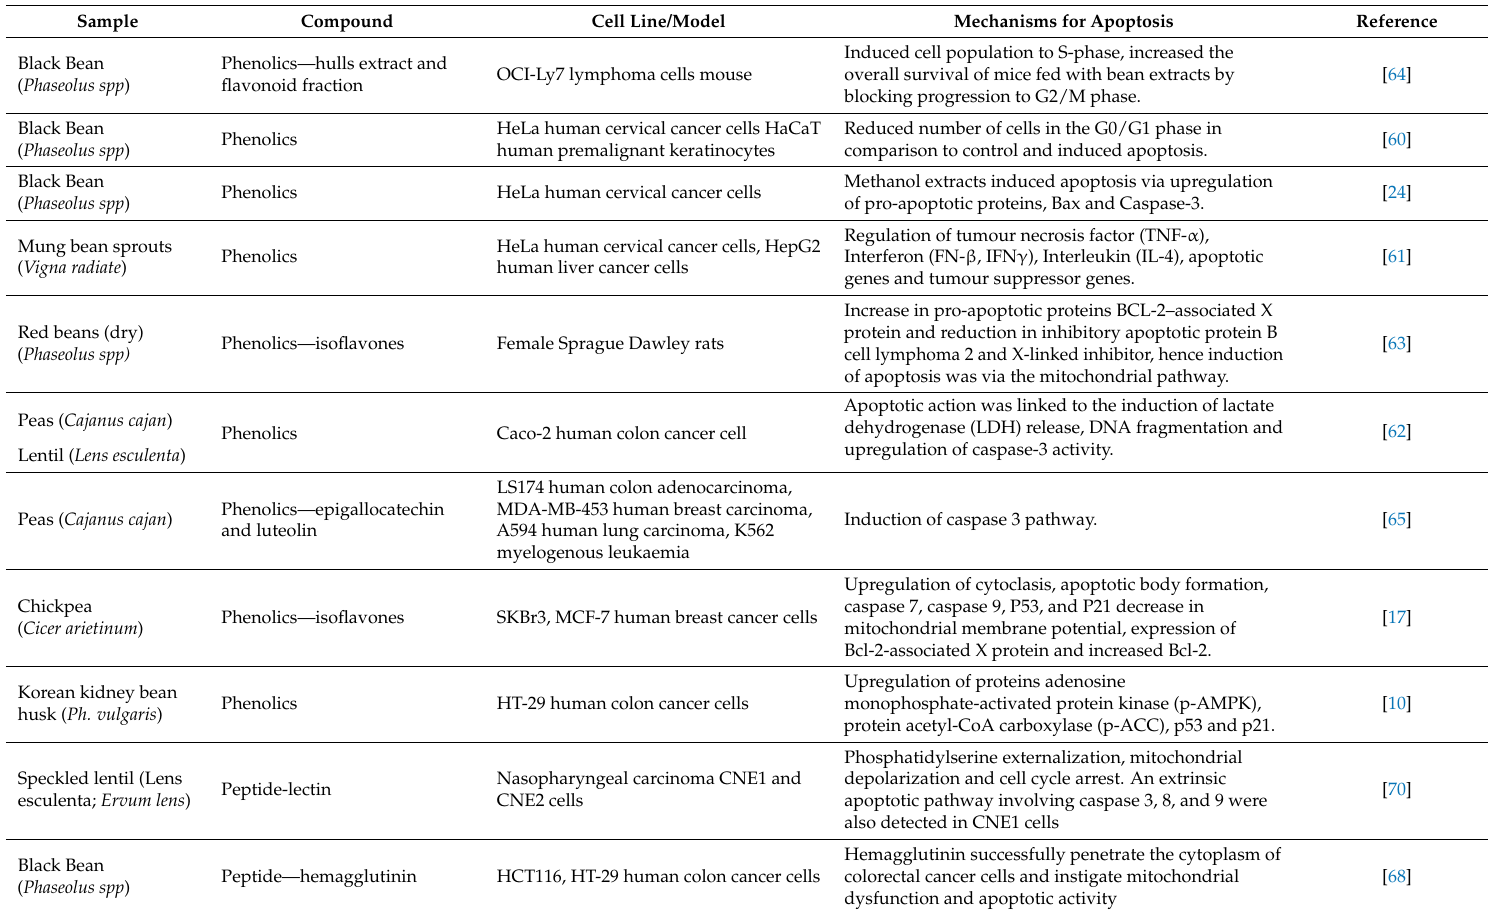
Table 2. Pro-apoptotic pathways initiated by pulse bioactive